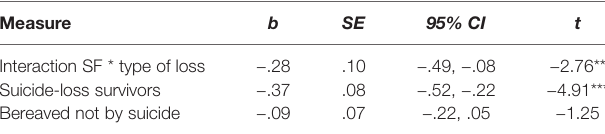
TABLE 3 | Moderation analysis in predicting suicidal ideation among suicide-loss survivors in compare to other bereaved individuals